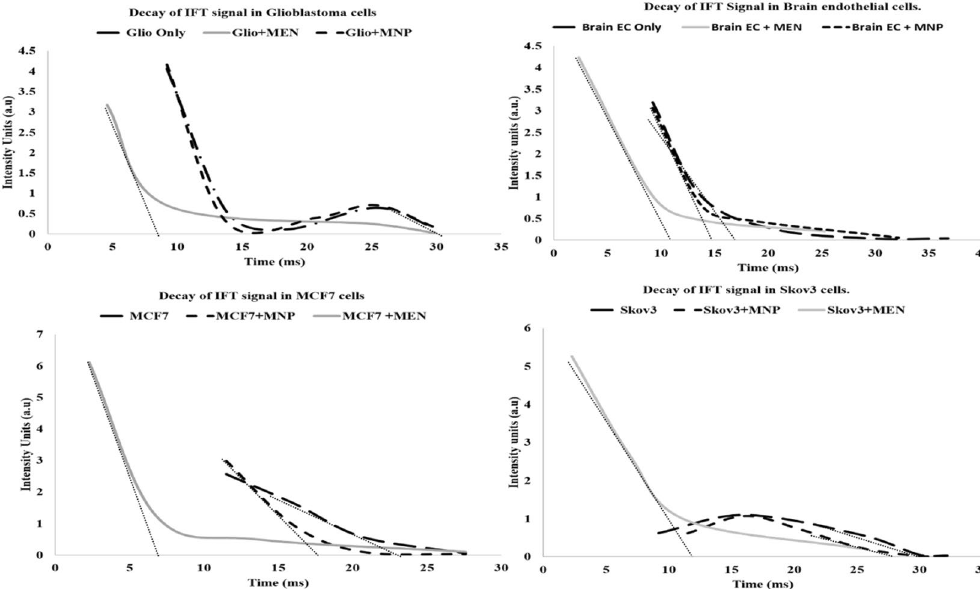
Figure 7. Inverse Fourier Transform (IFT) representation of CW-NMR spectra for Glioblastoma Brain EC, Skov3 and MCF7 with MENs and MNPs. The straight dotted slope lines indicate the approximate equilibration time for each type of measurement.